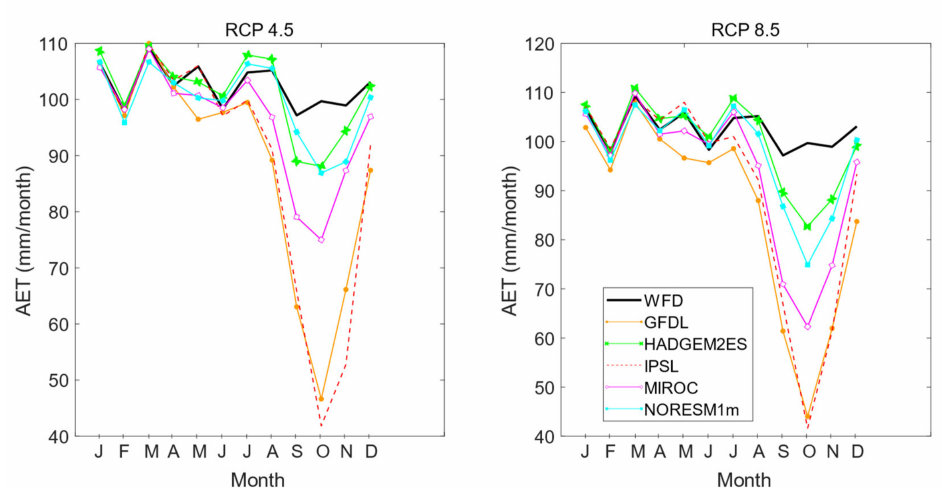
Figure 9. Seasonality of mean monthly AET (mm/month) in the IRB. The values are estimated for the reference and future periods for all GCM and the RCP4.5 and 8.5 scenarios.